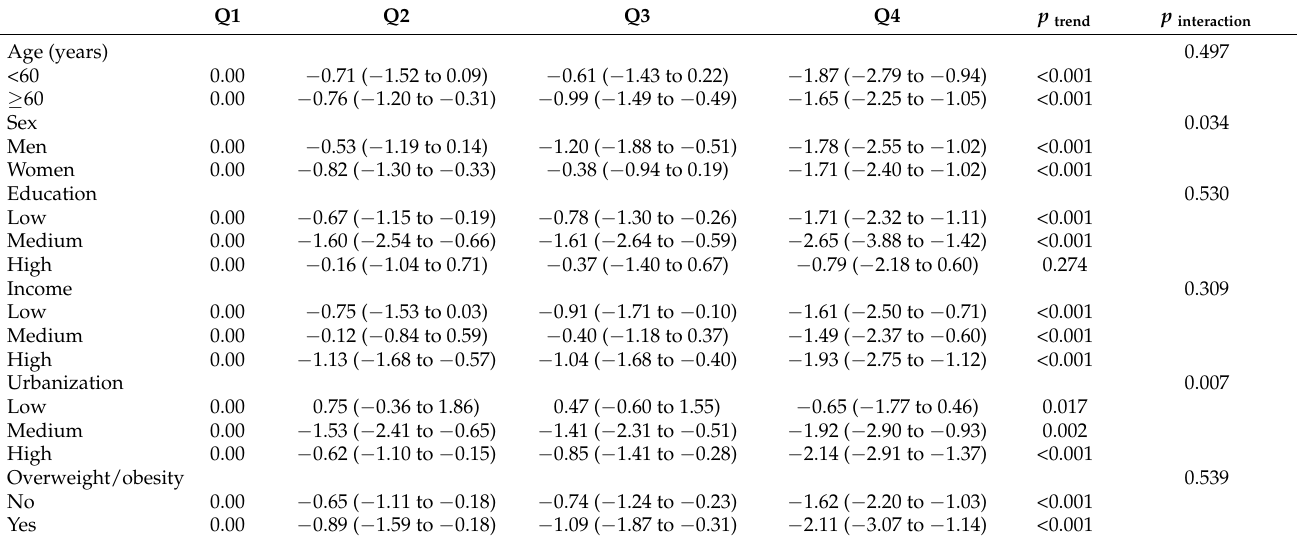
Table 4. Subgroup analyses of the associations between quartiles of plant methionine intake and global cognition